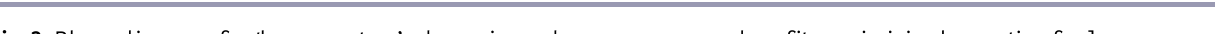
Fig. 3. Phase diagrams for the ecosystem’s dynamics under open access and profit-maximizing harvesting for low complementarity ( s = 0.95, left diagram) and high complementarity ( s = 0.05, right diagram) between ecosystem services in consumption. Dynamics are characterized by dx/dt > 0 (< 0) below (above) the green line, and dw/dt > 0 (< 0) left (right) of the red line. In the left phase diagram, A is an unstable equilibrium, B and C are locally saddlepoint-stable equilibria, D is the only and (almost) globally stable equilibrium; the corresponding basin of attraction comprises the entire state space with the exception of the axes (x = 0, w ‡ 0) and (x ‡ 0, w = 0). In the right phase diagram, A is an unstable equilibrium, B and C are locally stable equilibria; the corresponding basins of attraction consisting of the areas northeast (B) and southwest (C) of the saddlepath; D is a saddlepoint-stable equilibrium whose basin of attraction is just a one-dimensional line. Parameter values for both diagrams: r x = r w = 0.5, k x = k w = 1, g x = g w = 0, n x = n w = 1, a = 0.6, n =